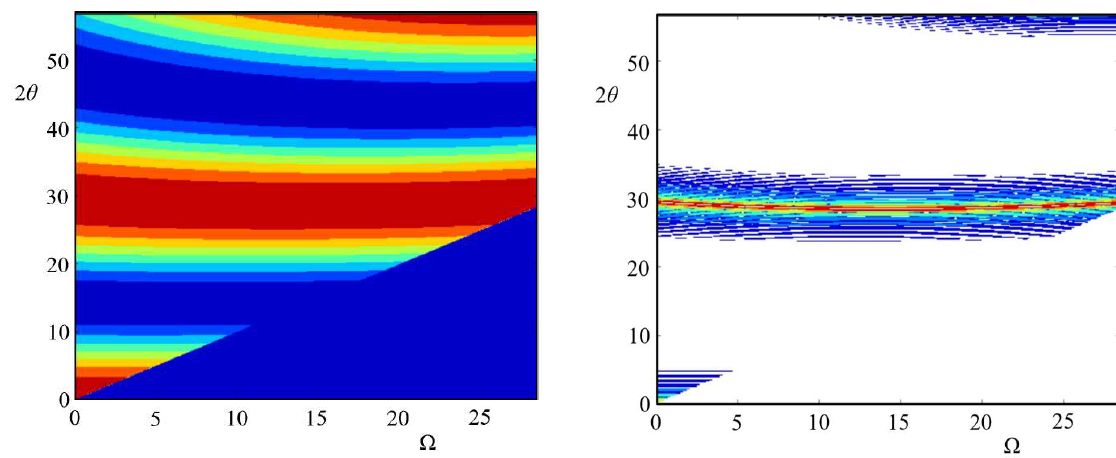
Figure 5. ( a ) The calculated scattering from two-point scatterers as the plane on which they sit is rotated (as in Figure 4). The intensity band at ~30 ° 2 θ is close to the Bragg scattering angle, over the whole range of incident and scattering angles above the planes. ( b ) The same calculation with a column of 100-point scatterers.